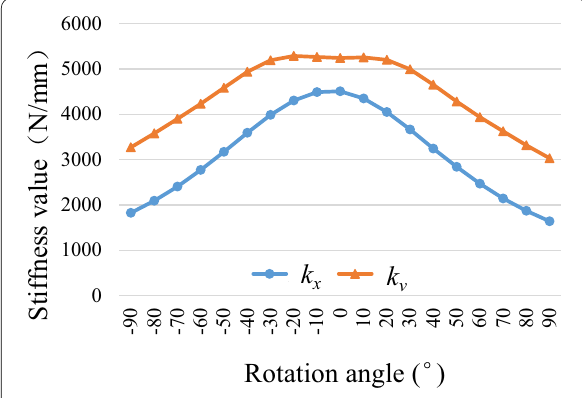
Figure 22 Stiffness fluctuation in Tag 4